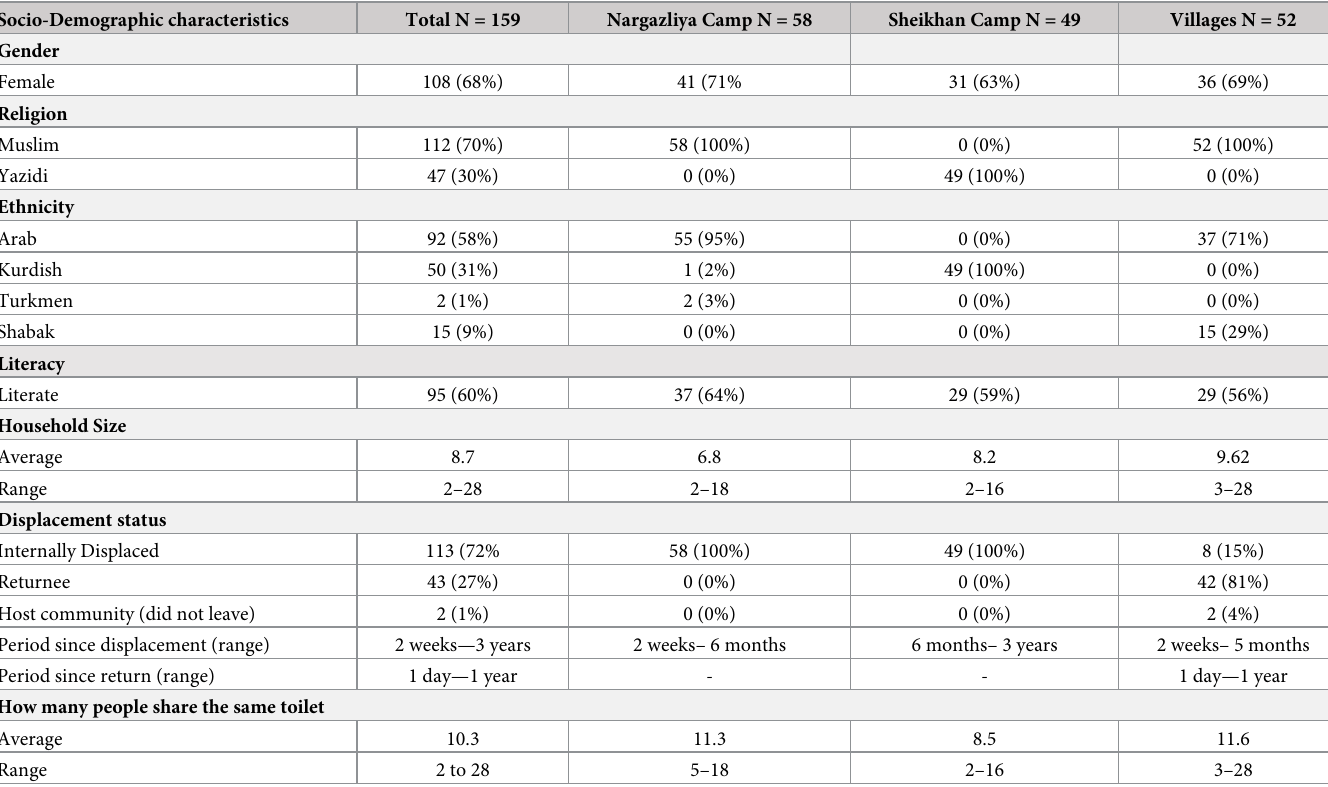
Table 3. Socio-demographic characteristics of all participants across the two camps and two